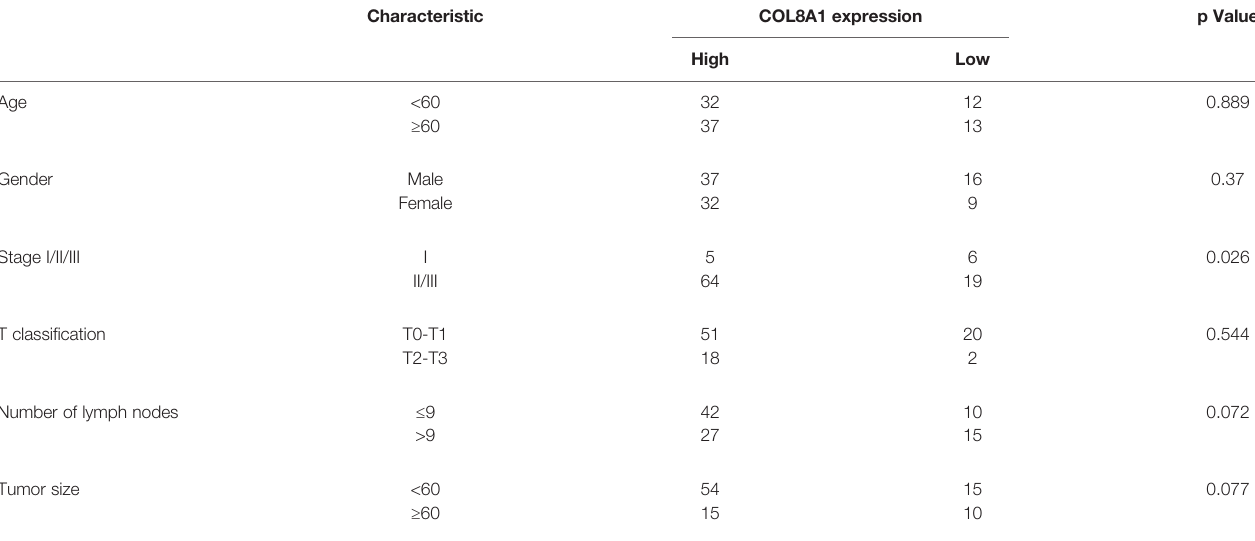
TABLE 2 | Correlation of COL8A1 expression with clinicopathological characteristics in 94 patients of NSCLC. Characteristic